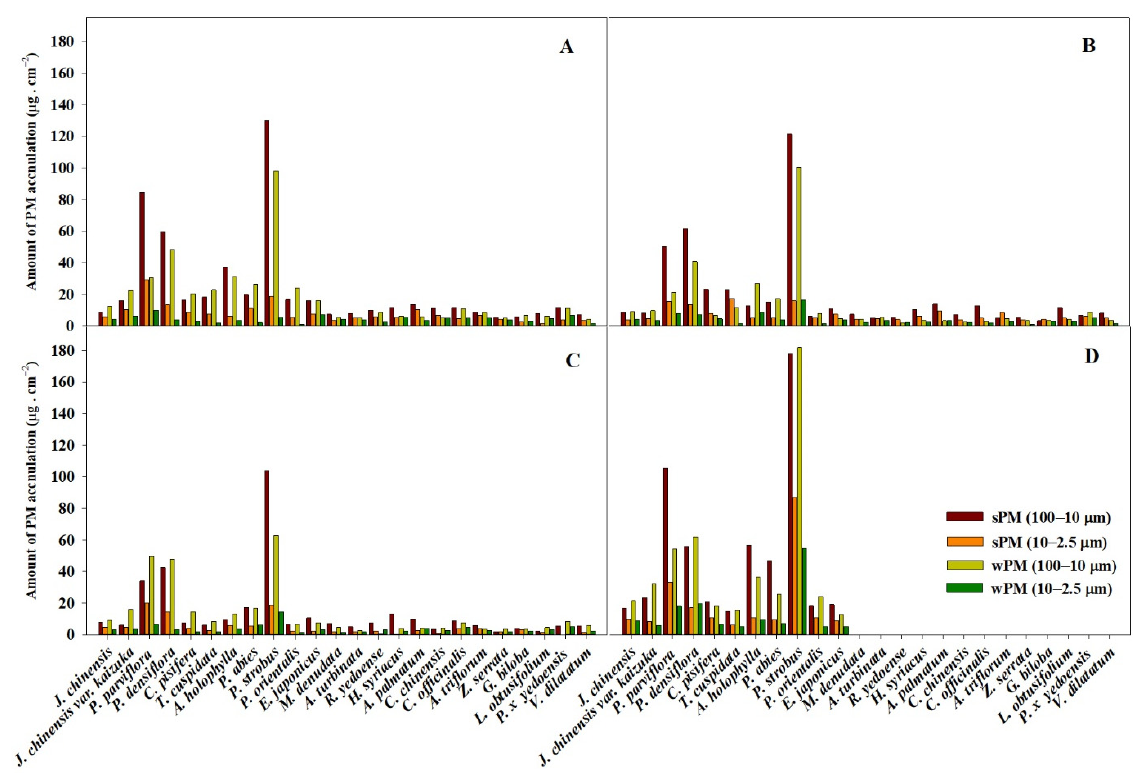
Figure 2. The amount of PM accumulation on the leaf surface and wax of 24 plant species. ( A ): Spring, ( B ): summer, ( C ): autumn, ( D ):